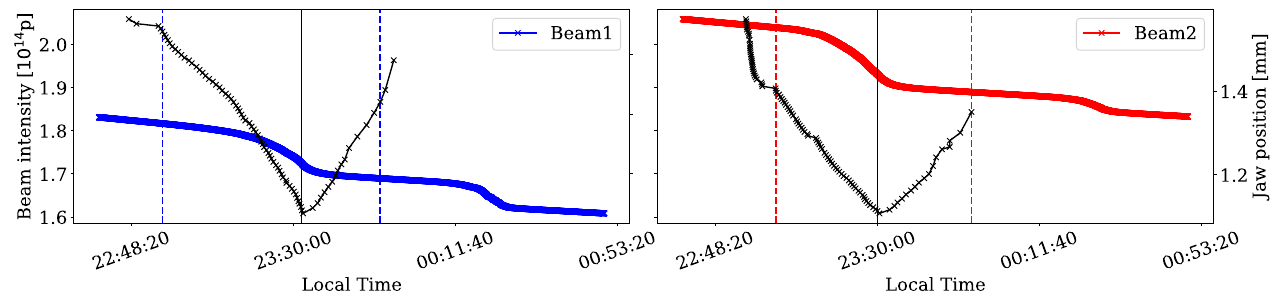
FIG. 8. Beam intensity and collimator jaw position during the scraping in fill 6052. The inward scraping was used to estimate the beam halo. The dashed lines represent the span of one experiment, for both inward and outward steps, whereas the solid black line marks the inversion of the collimator